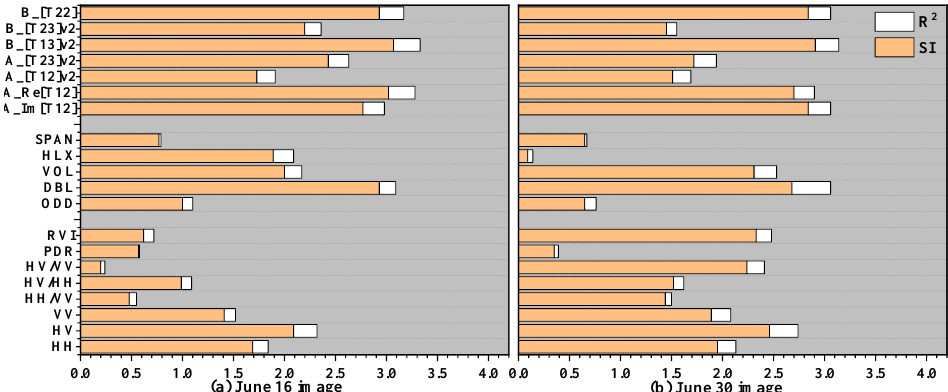
Figure 8. SI and R 2 of extracted features from two acquired quad polarimetric SAR images.